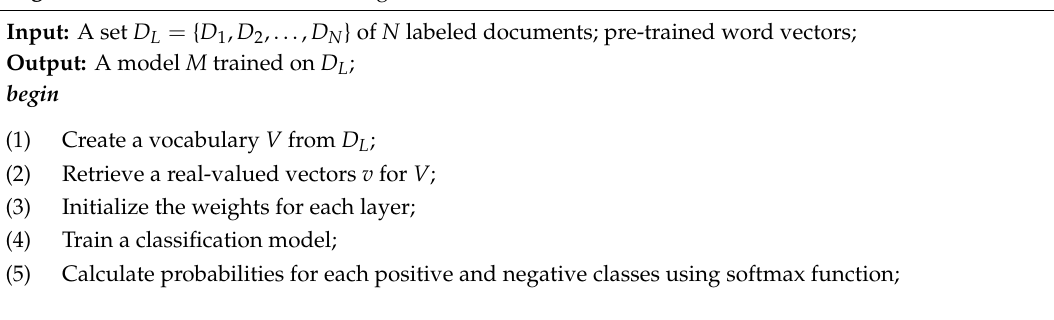
Algorithm 2 Cancer hallmark learning